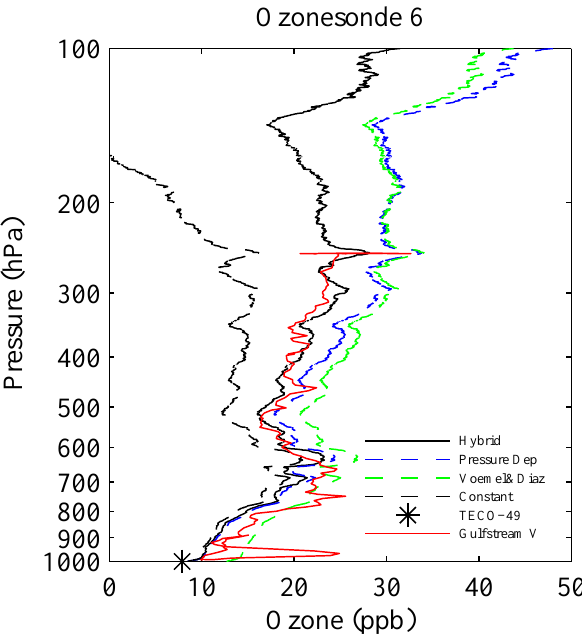
Figure 4. Ozone concentrations from CAST ozonesonde 6 on 5 February (black), and the segment of Gulfstream V flight RF09 that was close to Manus Island (red). The aircraft measurements most closely resemble the ozonesonde when the hybrid background correction is used (solid line), compared to the constant (black dot- ted line), pressure-dependent (red dotted line) and Vömel and Diaz (green dotted line) corrections. The asterisk is the ozone concen- tration measured by the TECO-49 on the ground on Manus Island. The peak in the aircraft data near the surface is caused by biomass